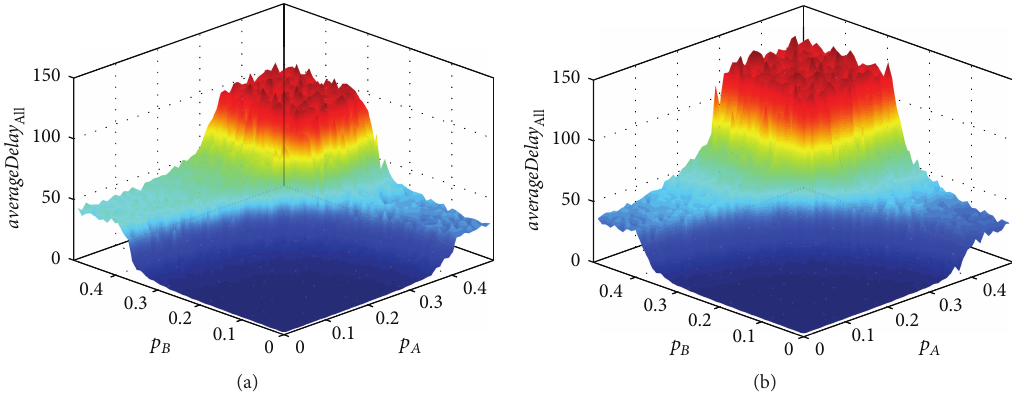
= 𝑝 = 0 and (b) 𝑝 UA UB